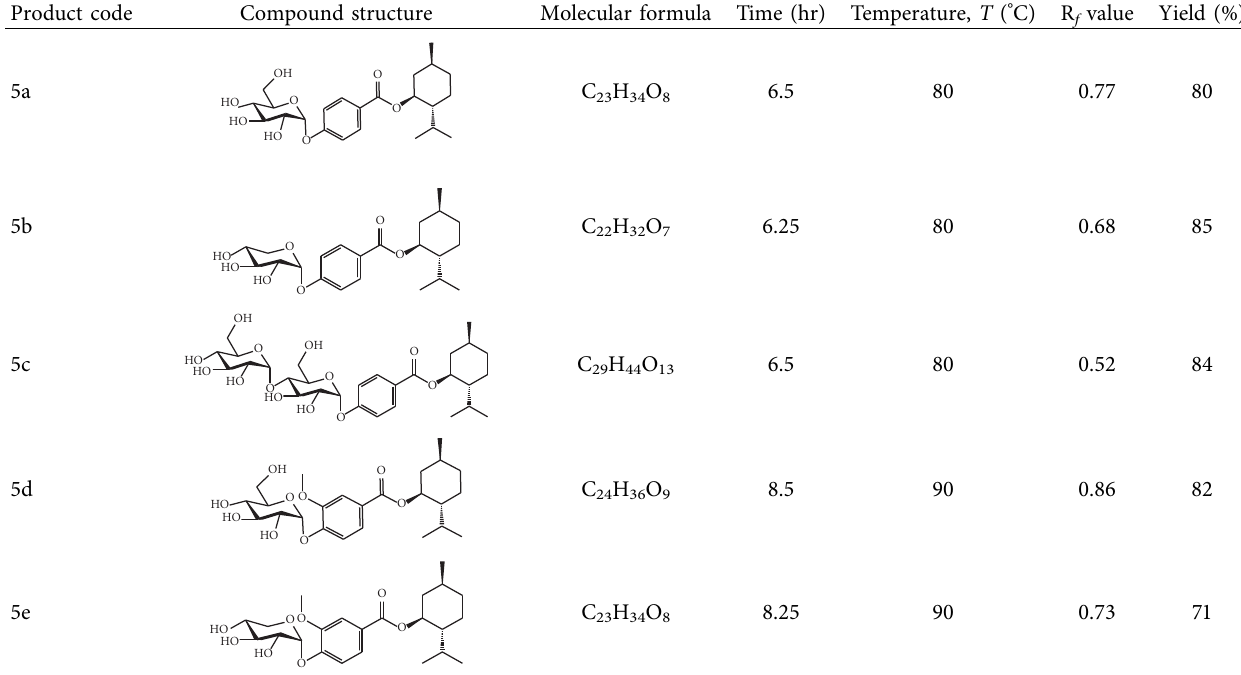
Table 7: Summary of physical data and reaction conditions of 5a–5l.